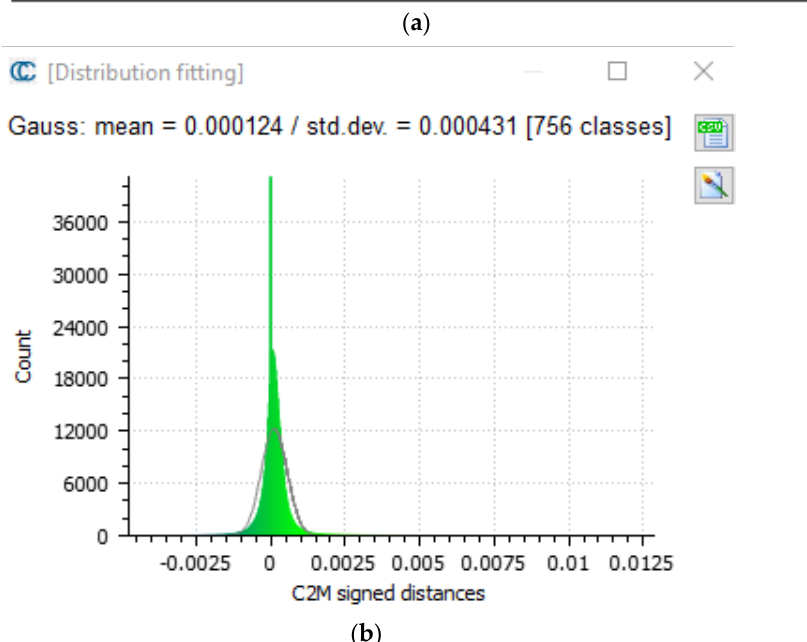
Figure 14. The comparison between the high resolution and the simplified retopologised model of the gladiator, where ( a ) is the graphical and visual comparison of the two meshes, and ( b ) is the gaussian distribution of the mean and the standard deviation calculated during the mesh-to-mesh comparison.